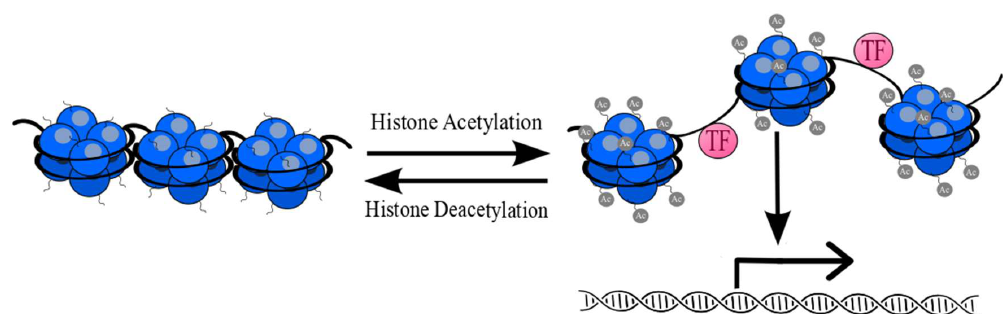
Figure 3. Reversible posttranslational acetylation of histones (blue). Acetylation of lysine residues causes relaxation of chromatin structure and provides easier access for transcription factors (TF) (pink). Removal of acetyl-groups (gray) from lysine residues leads to chromatin compaction and its inactivation [38].